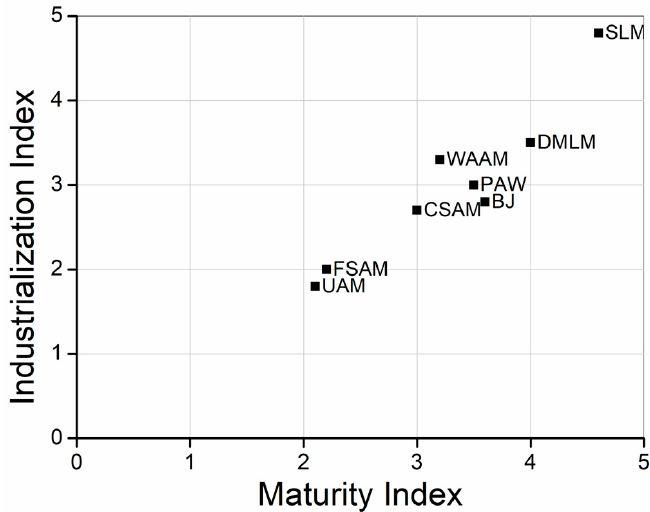
Figure 1. AM maturity index for producing metallic parts.